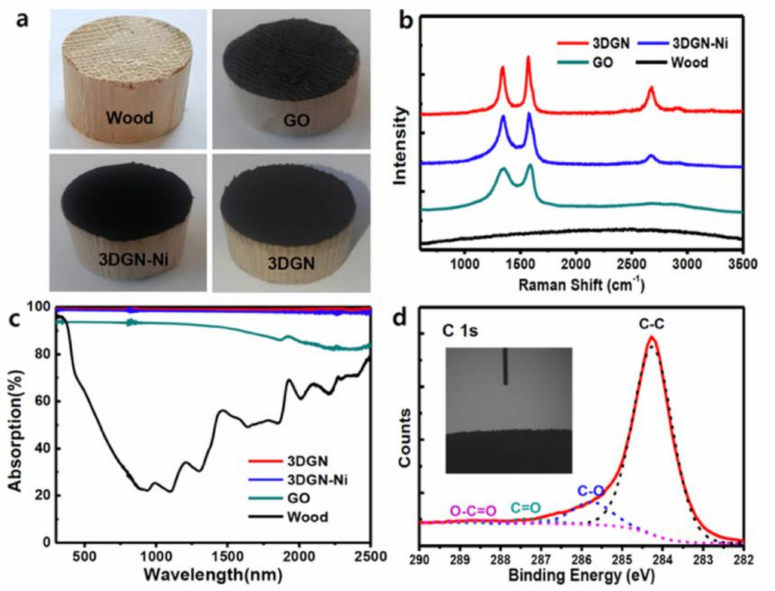
Figure 11. ( a ) DC image of the bare wood and GO, 3DGN-Ni, and 3DGN, on the wood; ( b ) Raman spectra; ( c ) UV–vis − NIR spectroscopy of wood, GO, 3DGN-Ni, and 3DGN; and ( d ) C 1s XPS spectrum of 3DGN [87] Reproduced with permission. Copyright 2018, American Chemical Society.